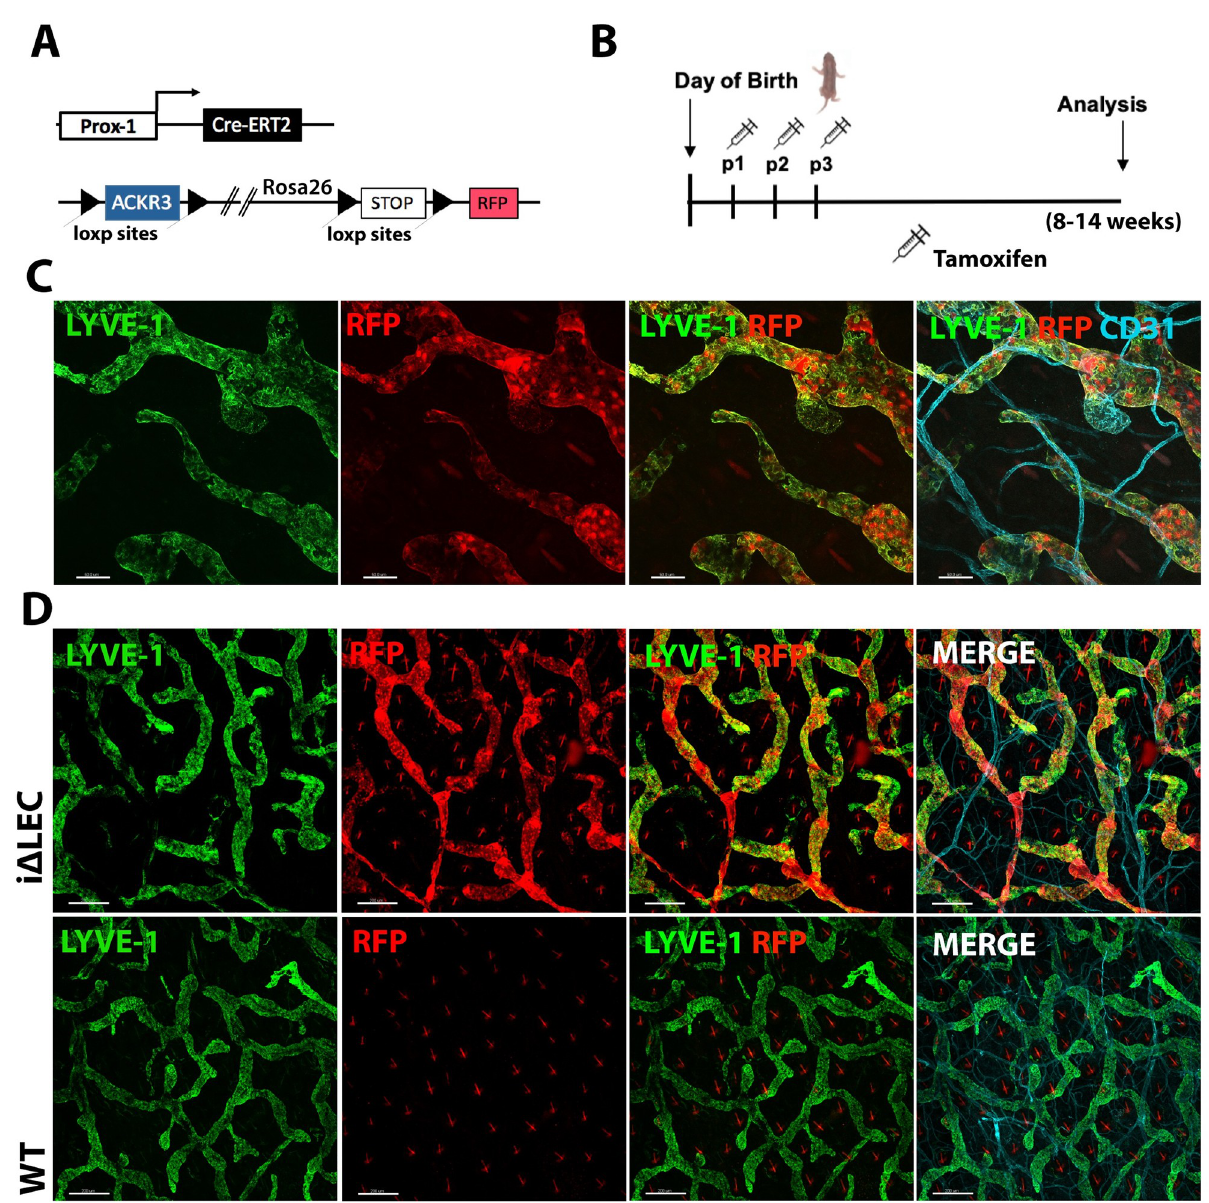
Fig 3. Generation of a lymphatic-specific knockout mouse model ( ACKR3 i Δ LEC ). (A) ACKR3 i Δ LEC animals express Cre ERT2 under the control of the lymphatic-specific Prox-1 promotor ( Prox-1 CreERT2 ). Ackr3 is flanked by loxp-sites, in addition to an inducible RFP in the Rosa26 locus. (B) Tamoxifen was administered to newborn pups from p1-p3 by daily intragastric injections. (C) RFP induction in CD31 + LYVE-1 + lymphatic endothelial cells in the ear skin of adult ACKR3 i Δ LEC mice. Scale bar: 100 μ m. ( D ) Overview: Almost uniform expression of RFP in lymphatic capillaries in ACKR3 i Δ LEC mice. No RFP signal in ACKR3 WT littermate controls. Scale bar: 200 μ m. Representative images of three independent experiments and 12 animals per genotype